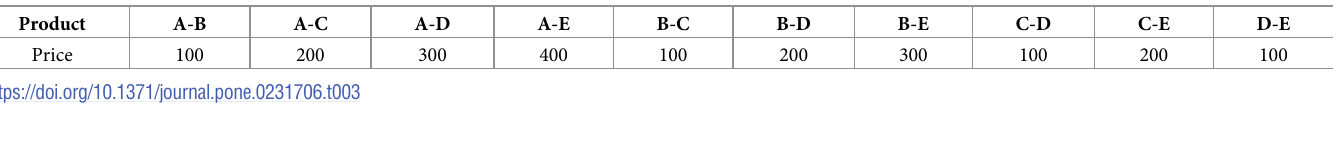
Table 3. Price of products.